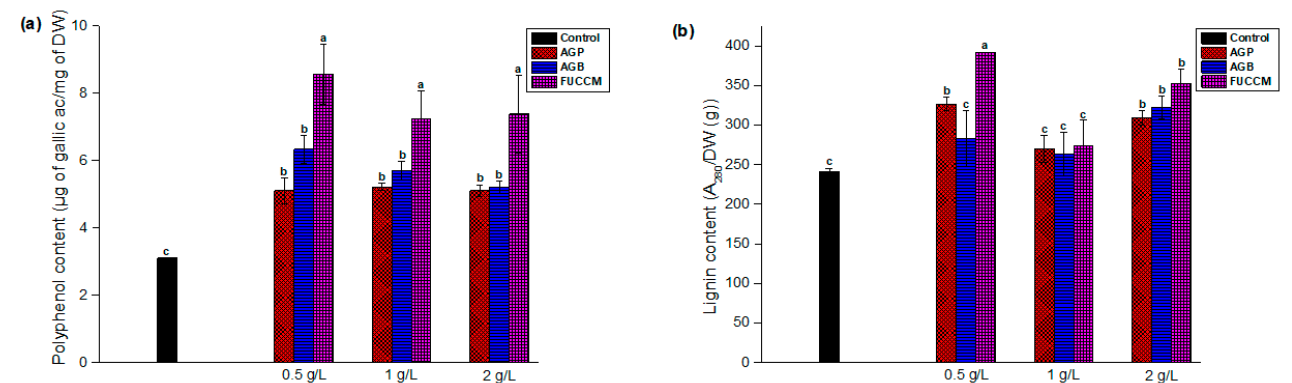
Figure 6. Effect of sulfated polysaccharides AGB and AGP extracted from CE and FUCCM isolated from CM on the induction of PAL ( a ) and TAL ( b ) activities in the leaves of olive tree after 24 h of treatment. The letters (a, b, c) indicate significant differences between treatments at each concentration using the Tukey-HSD test, at ( p < 0.05). Treatments presented with the same letter are not significantly different.